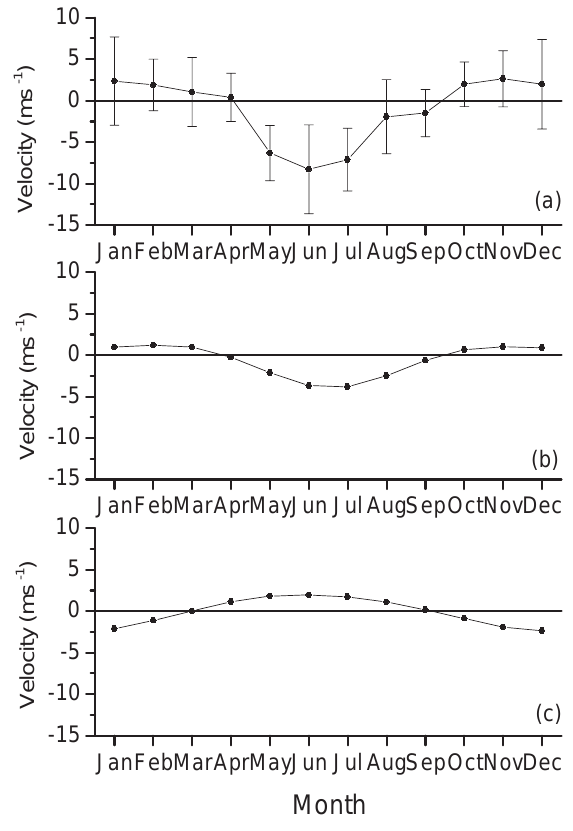
Fig. 2. Observed and model zonal winds (positive winds are east- wards): (a) Observed monthly-mean zonal wind, 1988–2000; er- ror bars indicate standard deviations. (b) CIRA-86 zonal winds for 93.3 km. (c) HWM-93 zonal winds for 90 km (d) HWM-93 zonal winds for 95 km.